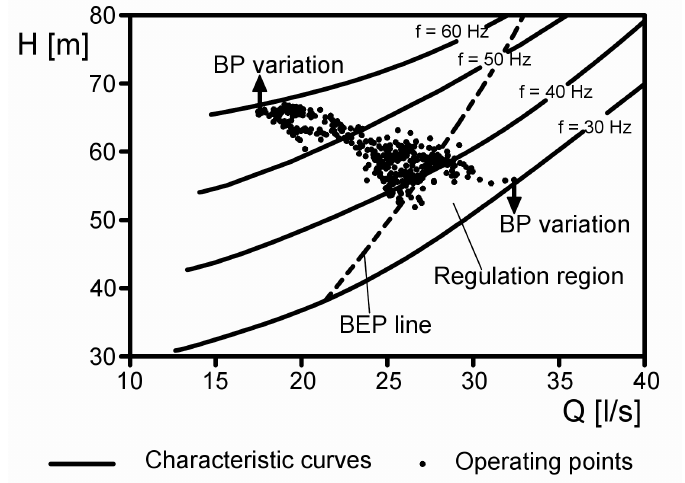
Figure 5. Regulation region and operating points for BP = 22 m and D = 210 mm